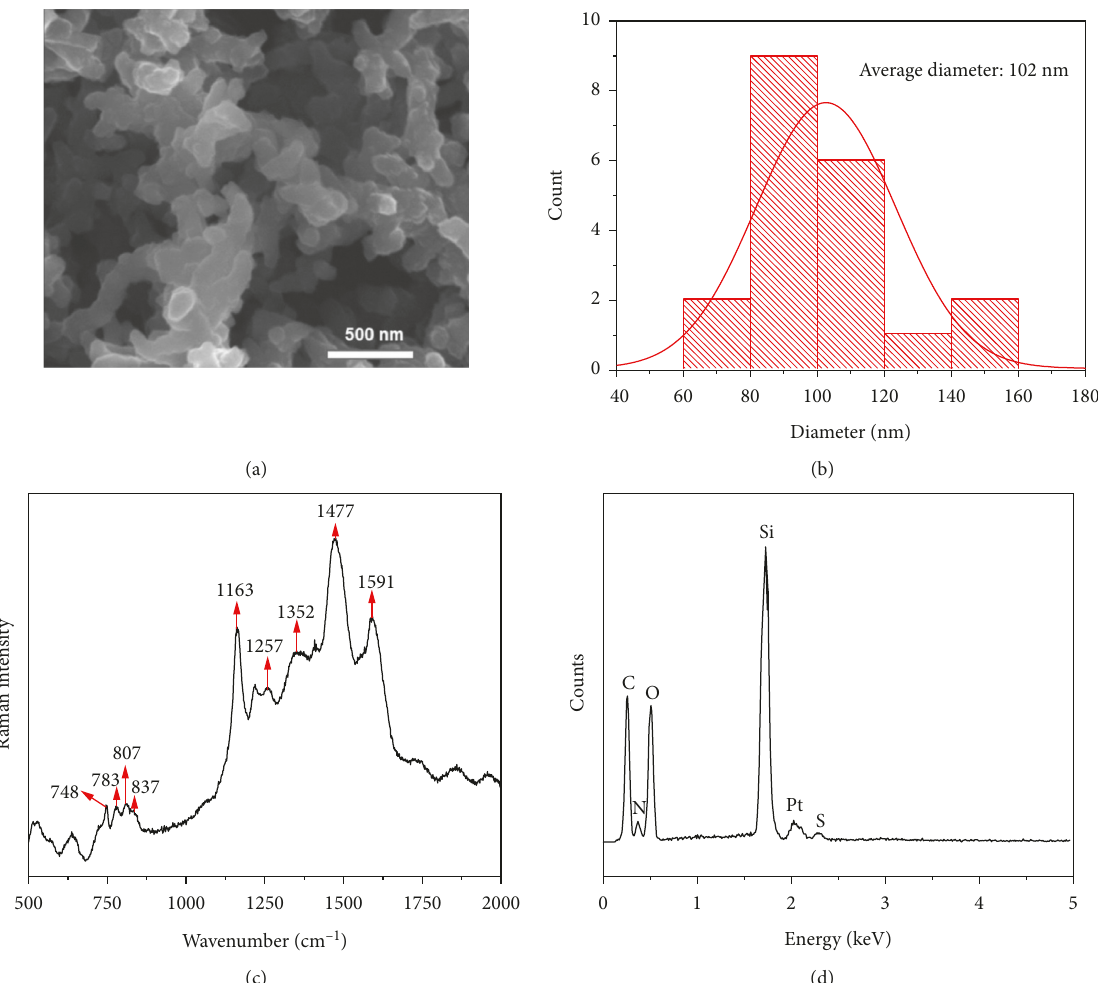
Figure 2: (a) SEM image, (b) nanowire diameter distribution, (c) Raman spectrum, and (d) EDX spectrum of PANi NWs electrosynthesized on Pt